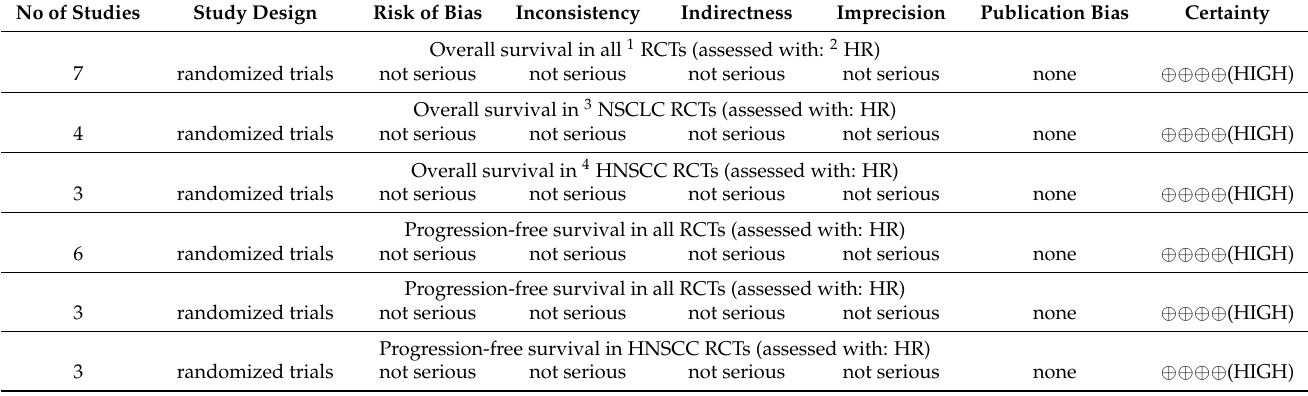
Table 3. Grades of the quality of evidence from RCTs enrolled in meta-analysis after application of sensitivity test.